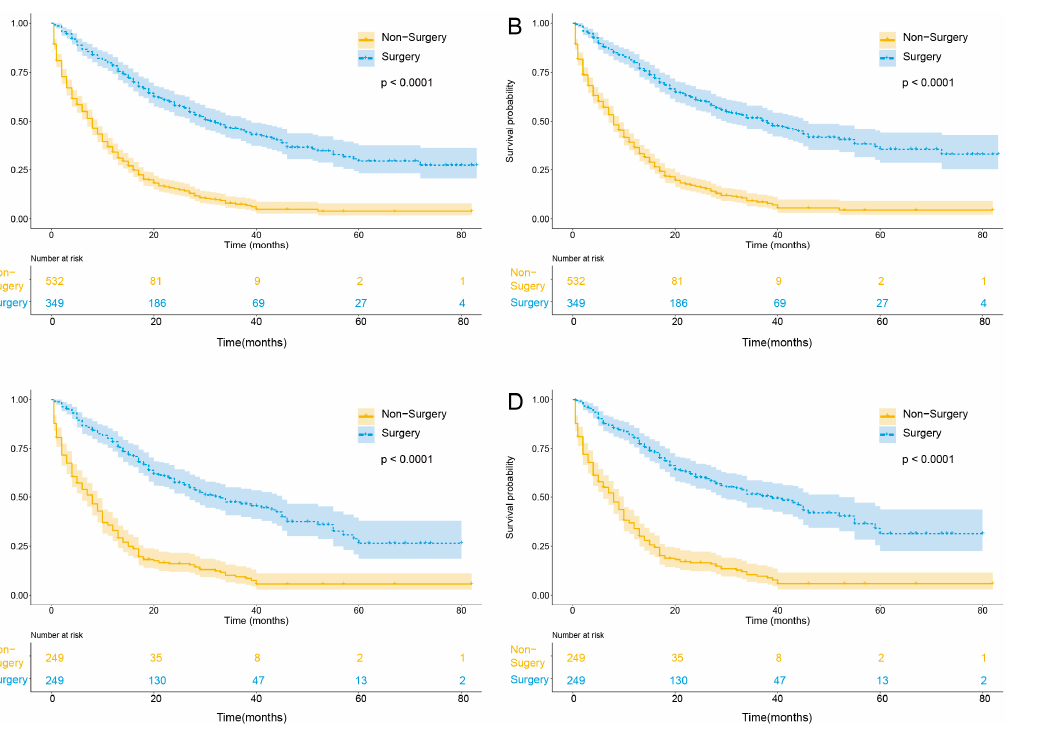
Figure 1. Kaplan–Meier curves of unadjusted OS ( A ), unadjusted CSS ( B ), adjusted OS ( C ), and adjusted CSS ( D ) stratified according to surgical treatment in M0 ICC patients above 60 years old. Abbreviations: OS, overall survival; CSS cancer-specific survival; M0, non-distant metastasis.